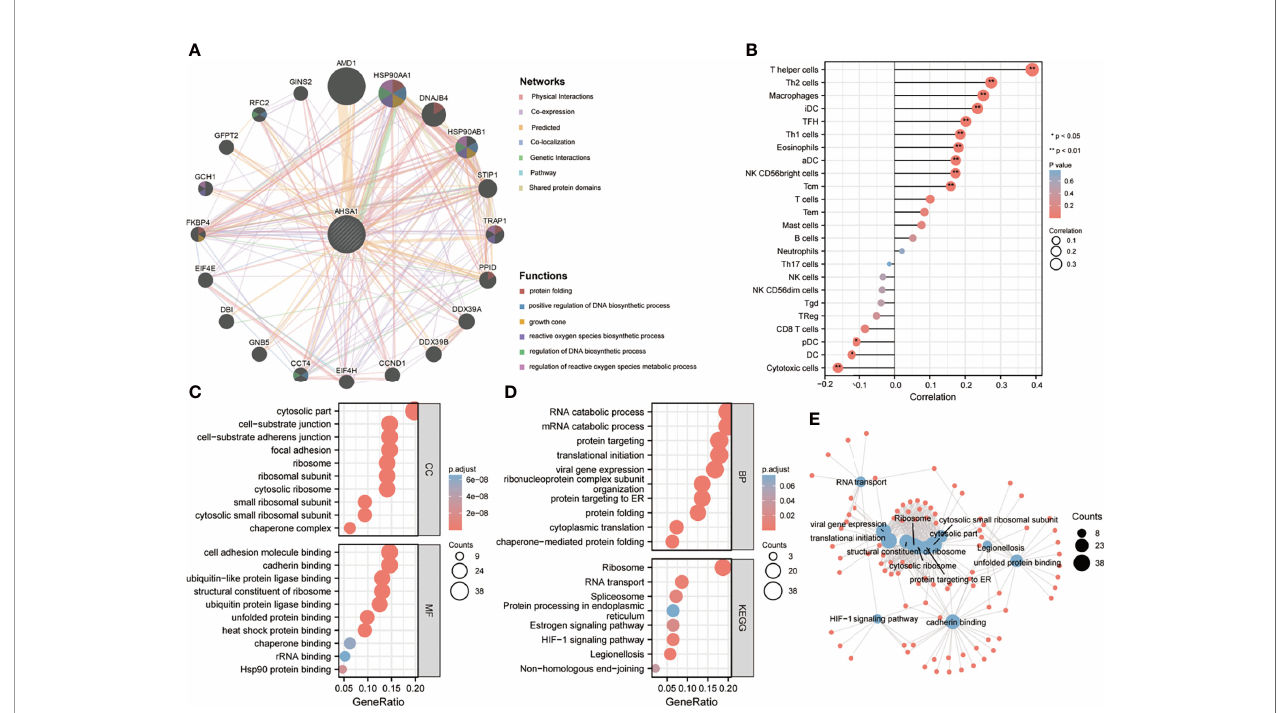
FIGURE 5 | Potential functions of AHSA1 . (A) The potential interaction molecular network of AHSA1 was created using the GeneMANIA. (B) The ssGSEA algorithm was employed to evaluate the abundance of immune cell in fi ltration in HCC. GO and KEGG functional enrichment analysis of the molecules interacted with AHSA1 (C, D) . (E) Construction of GO and KEGG interaction